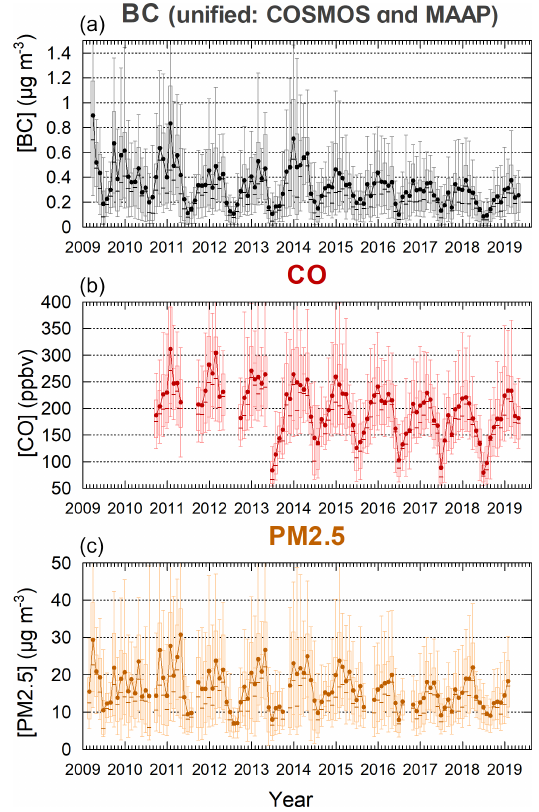
Figure 2. Monthly statistics of concentrations or mixing ratios of black carbon (BC), CO, and fine particulate matter (PM 2 . 5 ) at Fukue Island during 2009–2019. Average (dots), interquartile range (open box), range from the 10th to 90th percentile (error bars), and median (horizontal whiskers). BC measurements are from the continuous soot monitoring system (COSMOS) and a Multi-Angle Absorption Photometer